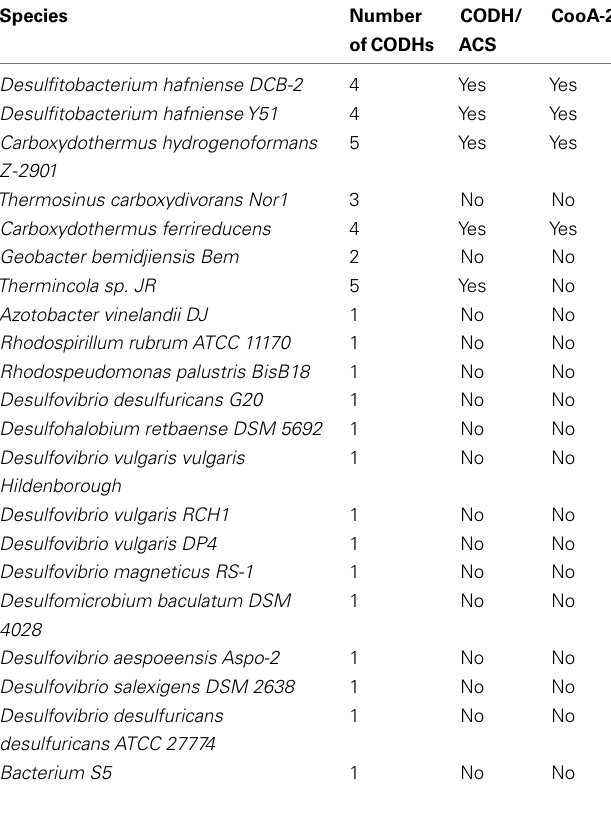
Table 1 | Occurrence of CooA-2 homologs and CODH/ACS operons in CO-oxidizing